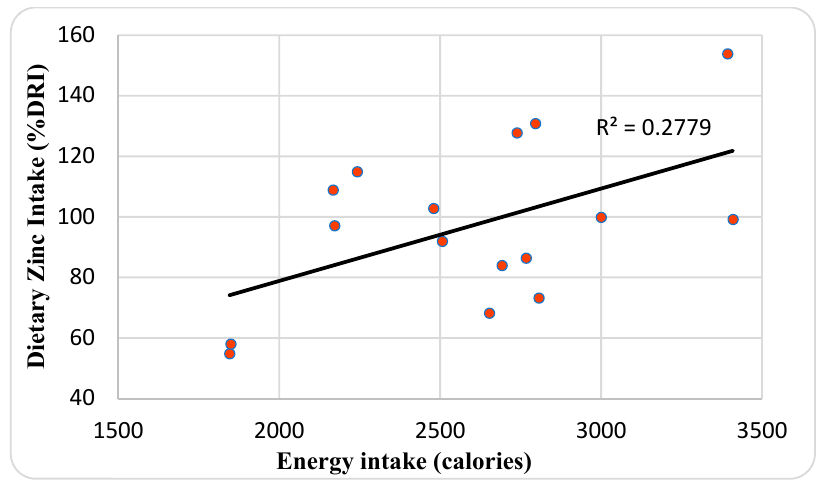
Figure 4. Relationship between dietary zinc intake and energy intake. %DRI: Percentage of Dietary Reference Intake.